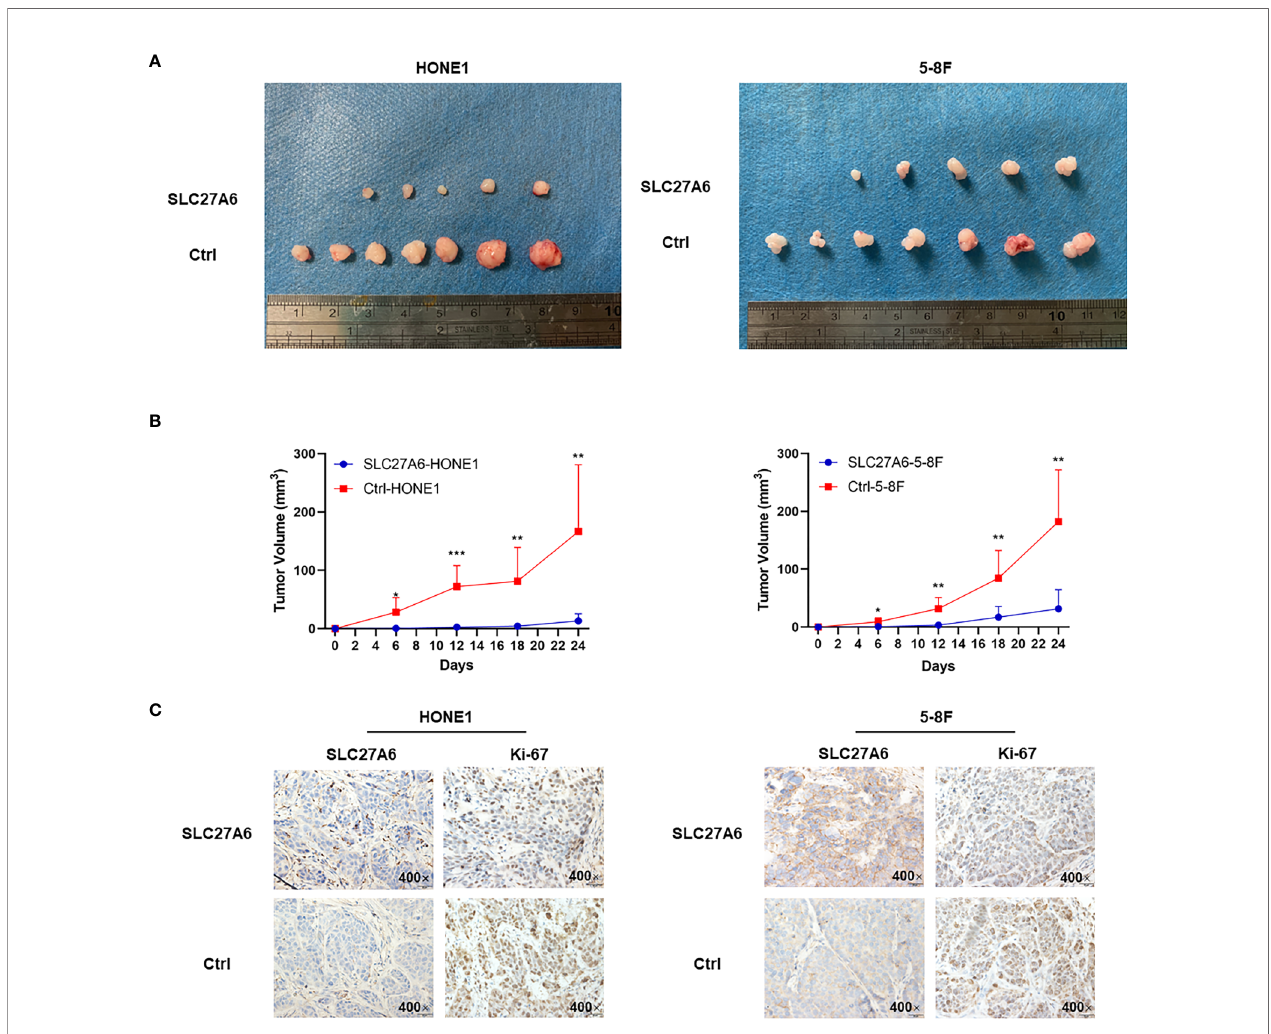
FIGURE 4 | Overexpression of SLC27A6 reduces NPC cells tumorigenesis in vivo . (A) Xenograft model in nude mice from injected SLC27A6-HONE1/5-8F or Ctrl- HONE1/5-8F cells (n=7). (B) The tumor growth of re-expression of SLC27A6 in SLC27A6-HONE1/5-8F and Ctrl-HONE1/5-8F cells-derived subcutaneous. (C) IHC staining of SCL27A6 and Ki-67 in xenografts. Magni fi cations ×400. * P < 0.05; ** P < 0.01; *** P <